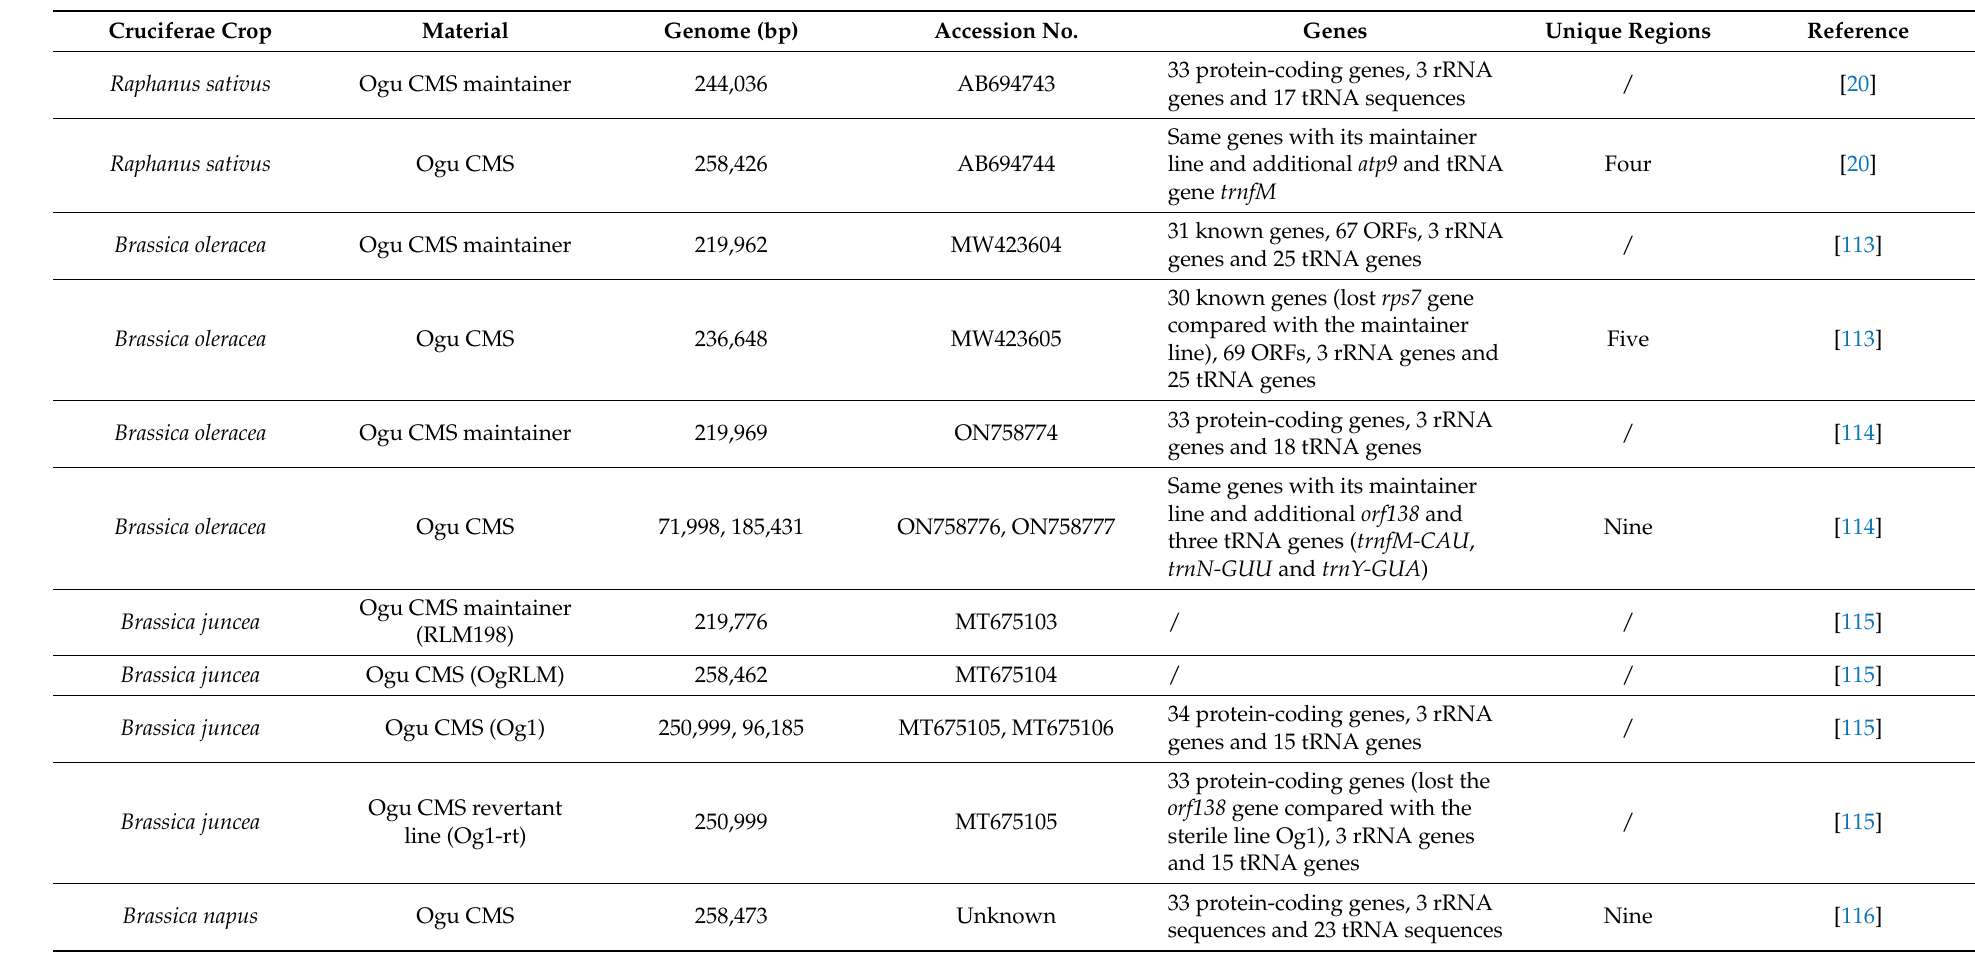
Table 1. Sequenced mitochondrial genome information for Ogura CMS sterile lines and corresponding maintainers in cruciferous